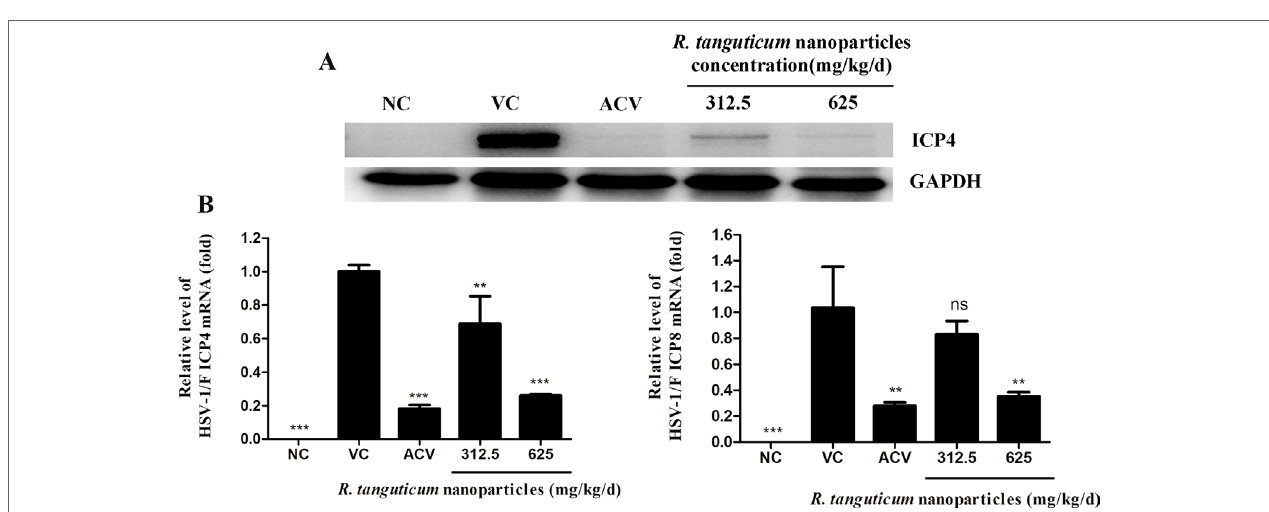
FIGURE 8 | R. tanguticum nanoparticles treatment reduced the genes and protein expression in HSV-1 infected mice. Kunming mice (n = 4 mice/group) infected with 5 LD 50 of HSV-1 were orally administered with 625 mg/kg/day, 312.5 mg/kg/day R. tanguticum nanoparticles, respectively. A 0.9% saline was used in viral control and normal control group. The mice were scheduled for sacrifice at 5 d.p.i. (A) The expression of the ICP4 protein of the brain tissue was detected by Western blot analysis. (B) The mRNA levels of the ICP4 and ICP8 in treated and control groups were determined by real-time quantitative PCR analysis. * p < 0.05; ** p < 0.01; *** p < 0.001; n.s., not